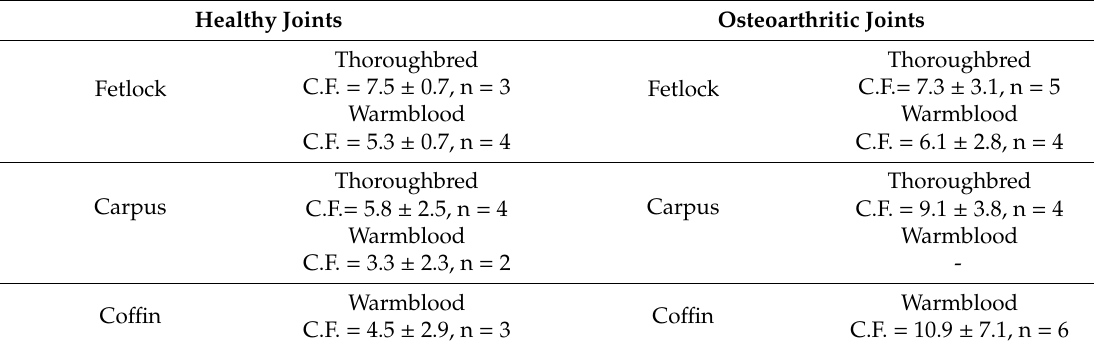
Table 6. Summary of all correction factors as a function of joint state, joint type and horse breed; C.F. = C HA, rheological / C HA, biochemical